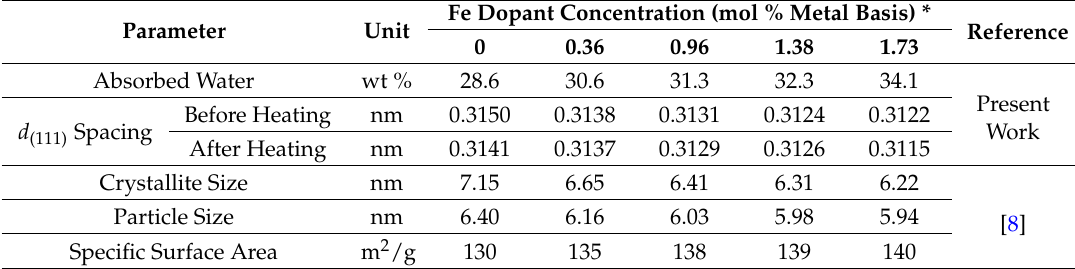
Table 1. Effects of the absorption of water vapor on Fe-doped CeO 2 .